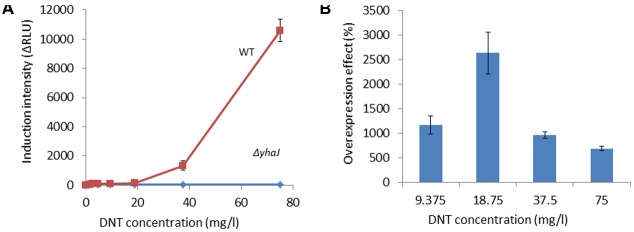
Induction of yqjF by DNT is abolished in a yhaJ mutant and enhanced when YhaJ is overexpressed.
(A) Induction intensity (maximal luminescence recorded within 300 min of exposure) of yqjF as a function of DNT concentration in a ΔyhaJ mutant and the WT. (B) Effect of overexpressed YhaJ on yqjF induction by several DNT concentrations. Calculation of the overexpression effect is as detailed in Section “Materials and Methods.” Error bars represent the standard deviation of at least three independent duplicate experiments.